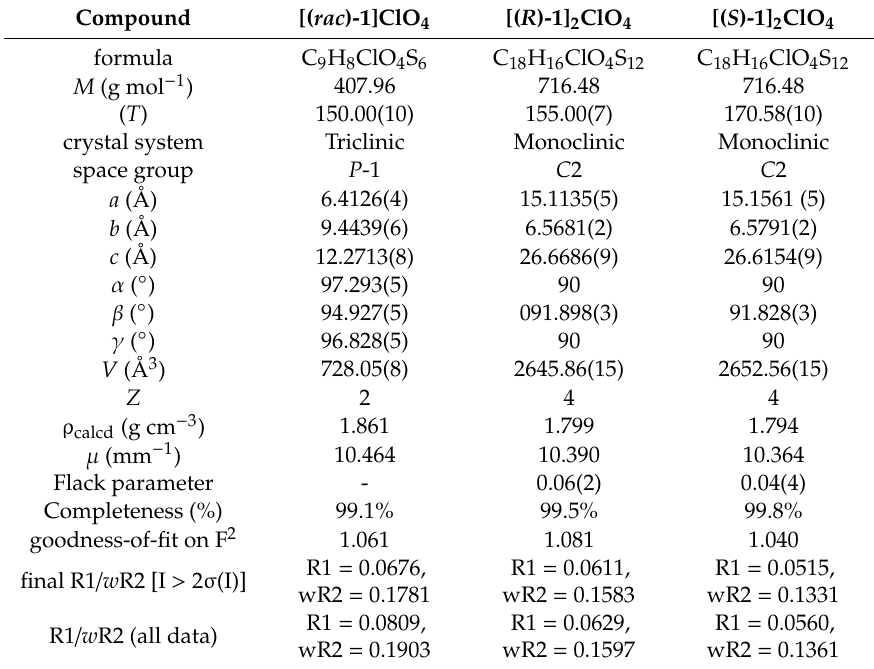
Table 1. Crystal Data for compounds [( rac )- 1 ]ClO 4 , [( R )- 1 ] 2 ClO 4 and [( S )- 1 ] 2 ClO 4 .